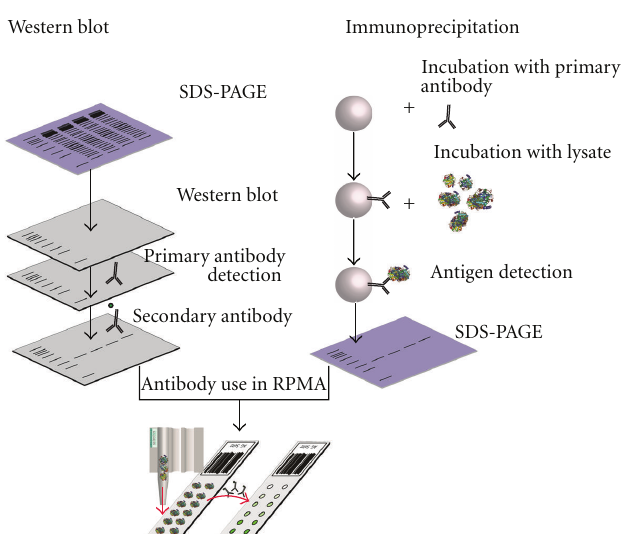
Figure 2: Strategy for antibody validation; only if single bands can be detected, the antibody can be used in microarray